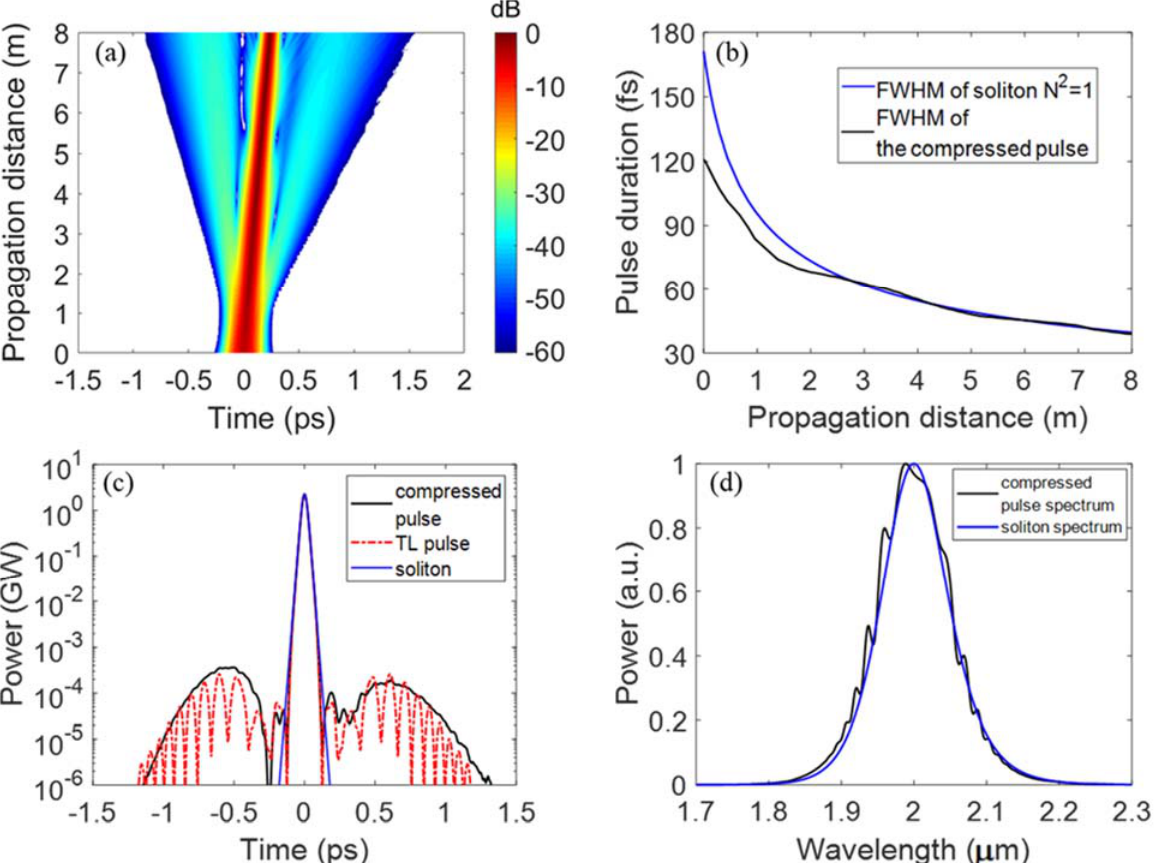
Figure 4. ASC of a positively pre ‐ chirped 120 fs, 100 μ J pulse at 2 μ m. ( a ) Pulse evolution as a function of propagation distance. The intensity is shown in log scale. ( b ) FWHM of a fundamental soliton (blue curve) and FWHM of a compressed pulse (black curve) versus the propagation distance. ( c ) Compressed pulse (black curve) and transform ‐ limited (TL) pulse (red dashed curve) at HCF output. The fundamental soliton is shown as the blue curve. ( d ) Optical spectrum (black curve) and soliton spectrum (blue curve) at HCF output.